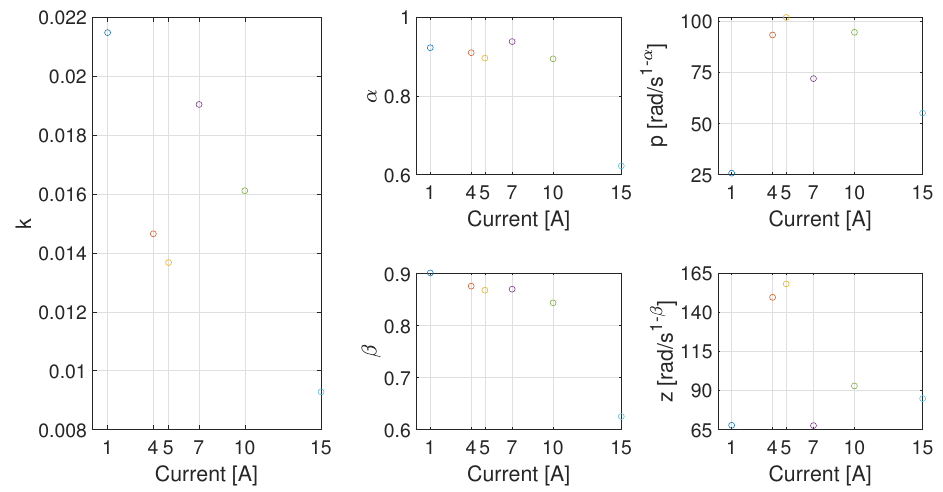
Figure 13. Parameters plot for each analyzed working current point.